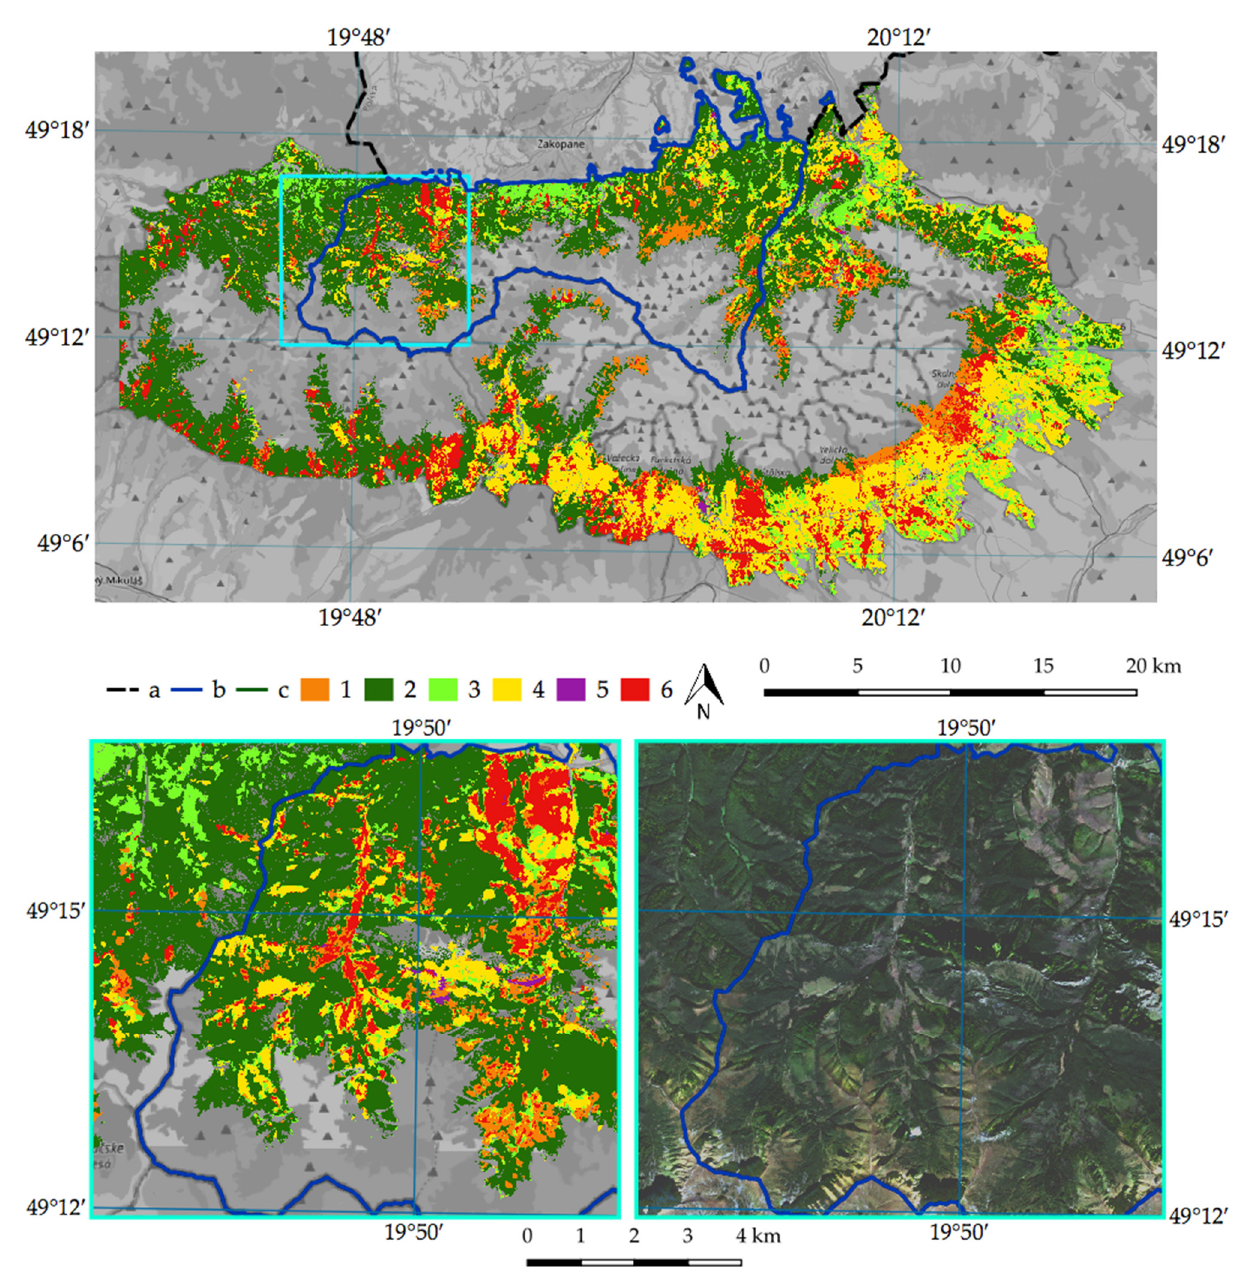
Figure 3. Sentinel-2 image-based map of the Tatra land cover: (a) country border; (b) border of the Polish TPN; (c) border of the Slovak TANAP; (1) snags; (2) coniferous forests; (3) deciduous forests; (4) grasslands; (5) rocks; (6) cuts or windthrow areas. A map from OpenStreetMap was used in the background and Sentinel-2 RGB 432 composition, 3 October 2015.